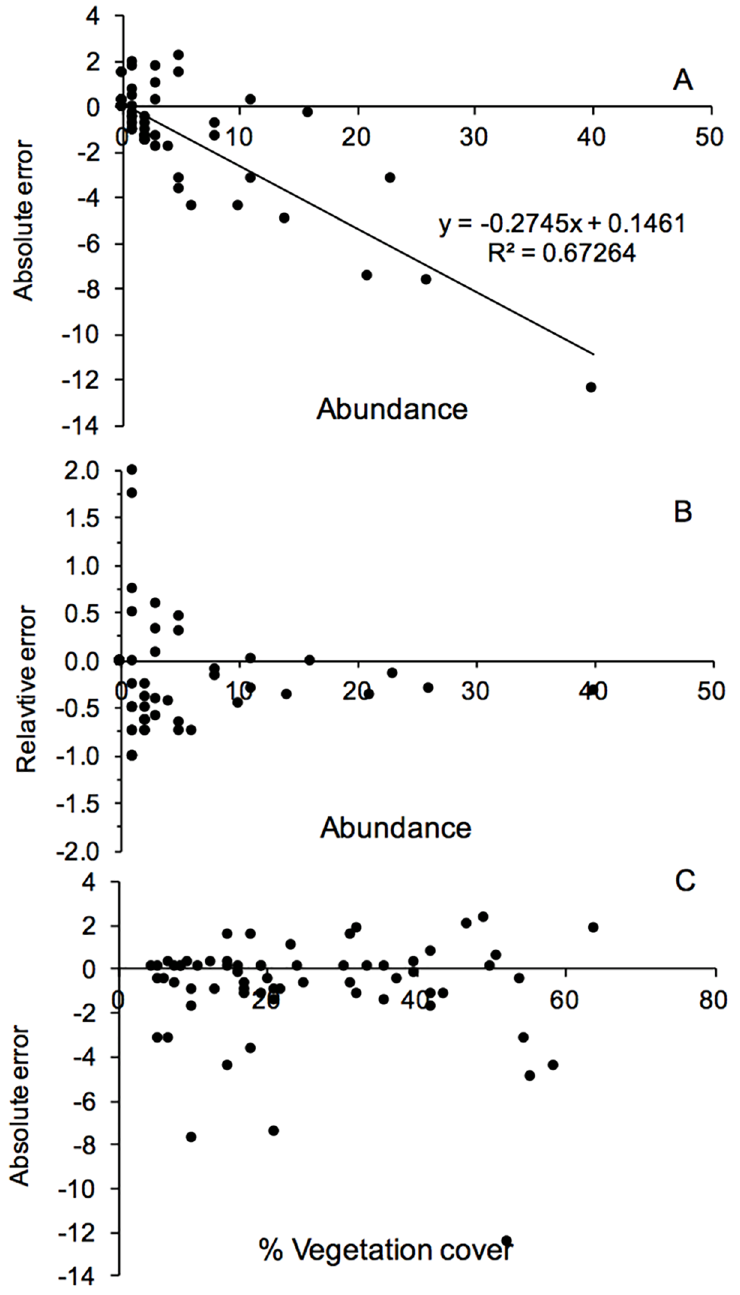
Fig 6. Examination of errors. Errors in observedabundancesof Ostrea edulis (i.e. video estimation–field examination) as a function of abundance (A) absolute error, (B) relativeerror and (C) % vegetationcover.